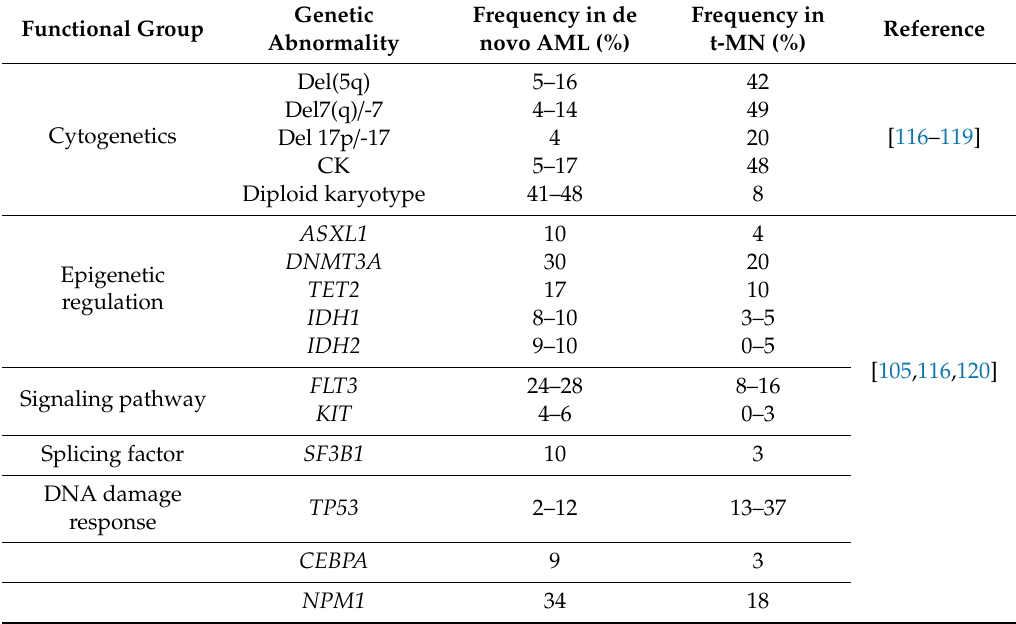
Table 5. Comparison of cytogenetic and molecular abnormalities in therapy-related myeloid neoplasm (t-MN) with de novo